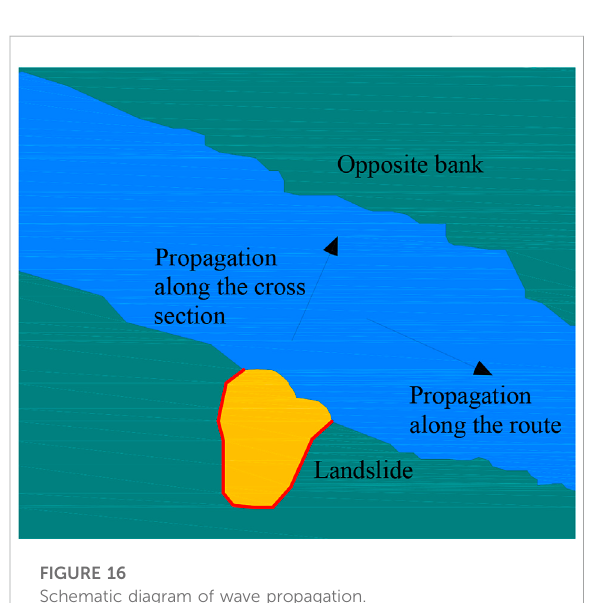
FIGURE 16 Schematic diagram of wave propagation.